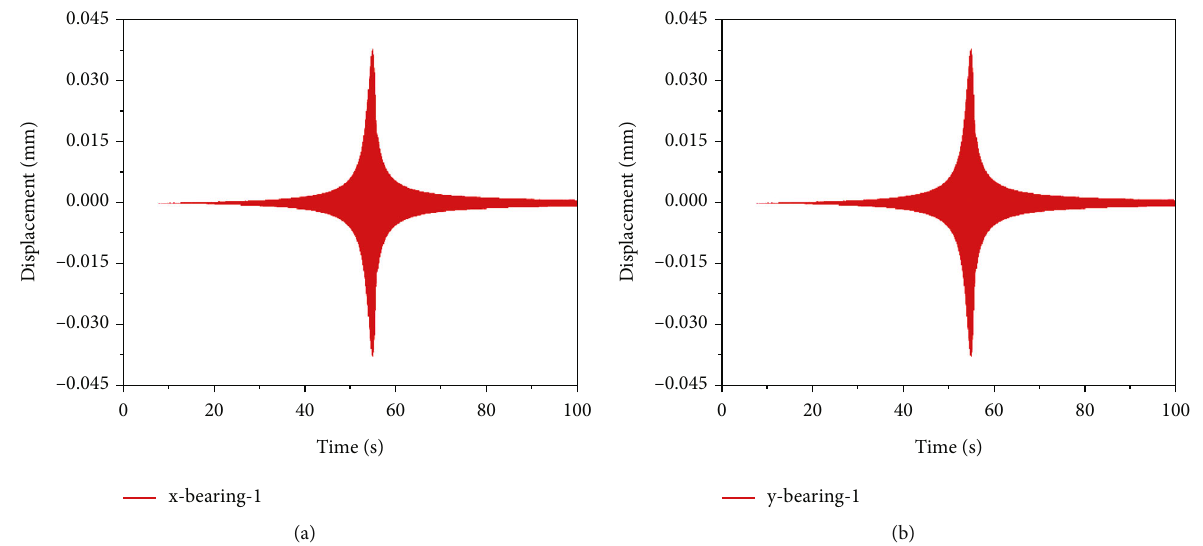
Figure 17: Time-domain response diagram of the nodes at the rear bearing in case 1. (a) Response in the x -axis direction. (b) Response in the y -axis